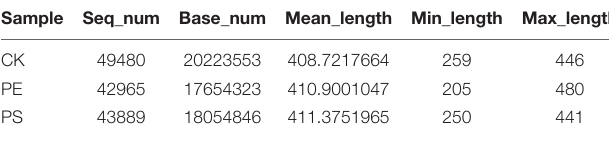
TABLE 1 | Sequencing data statistics for the different